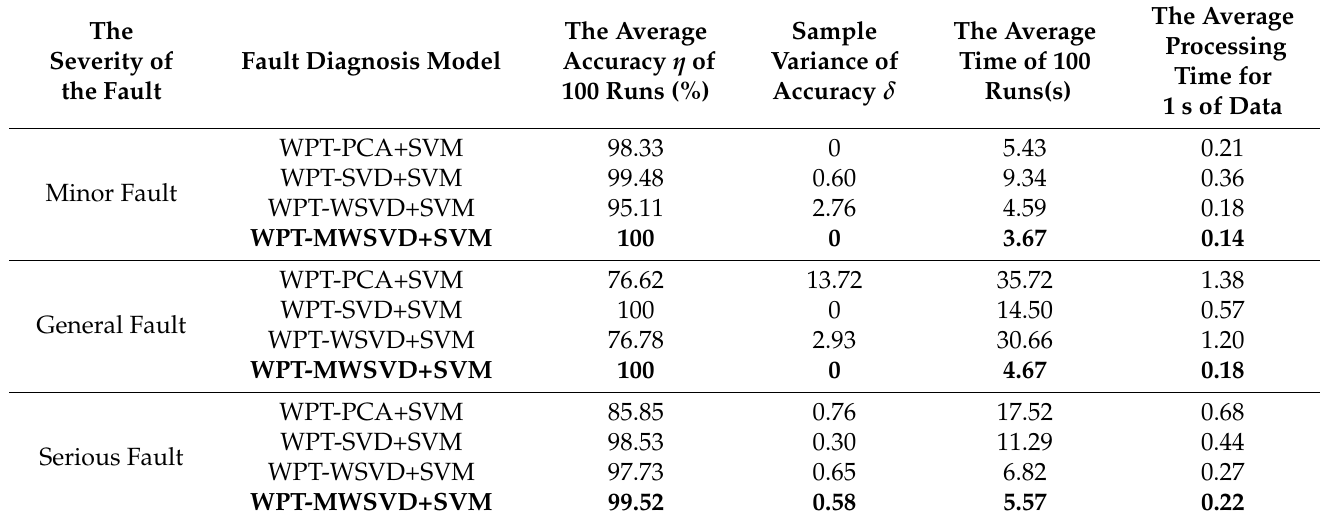
Table 7. Failure status label for each degree of fault.